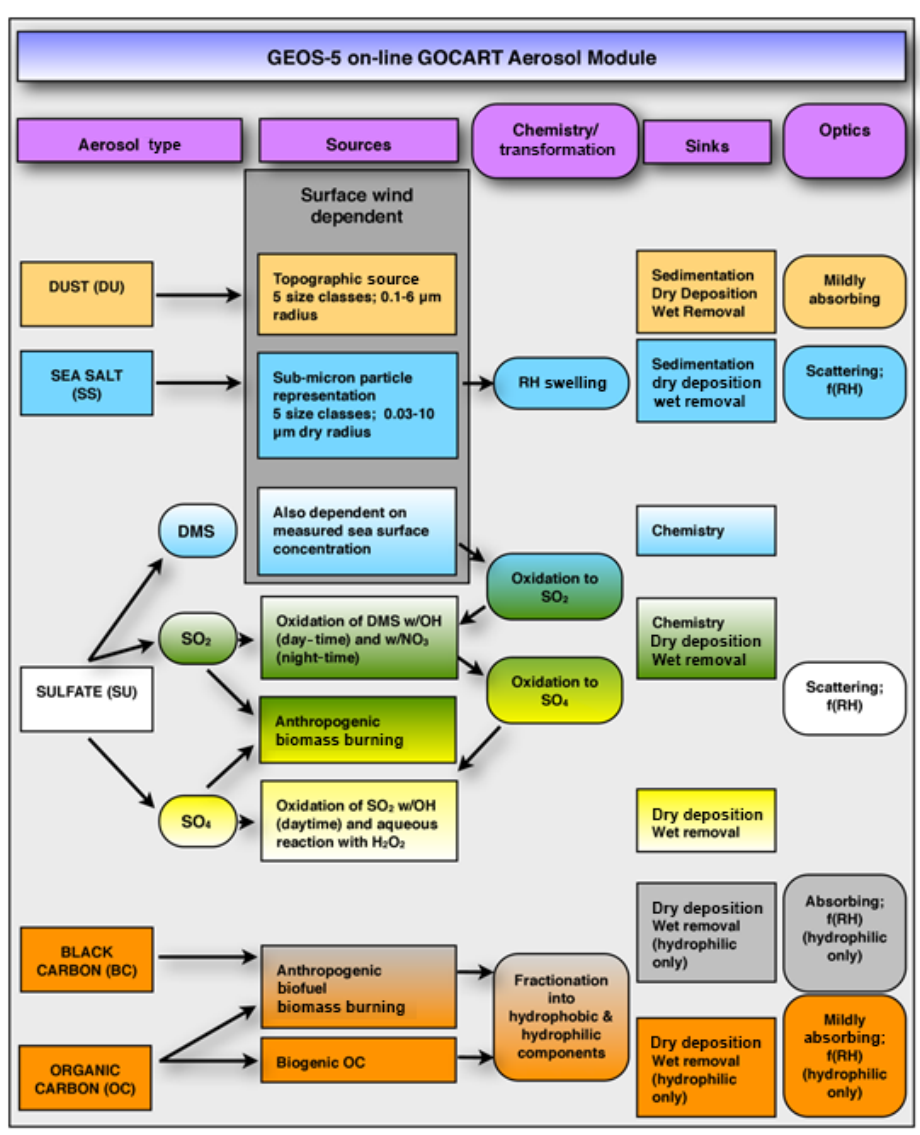
Figure 1. Summary of aerosol modules in GEOS5 (Colarco et al., 2010). This aerosol module is adopted NGACv2. (Provided by Peter Colarco, NASA/GSFC,